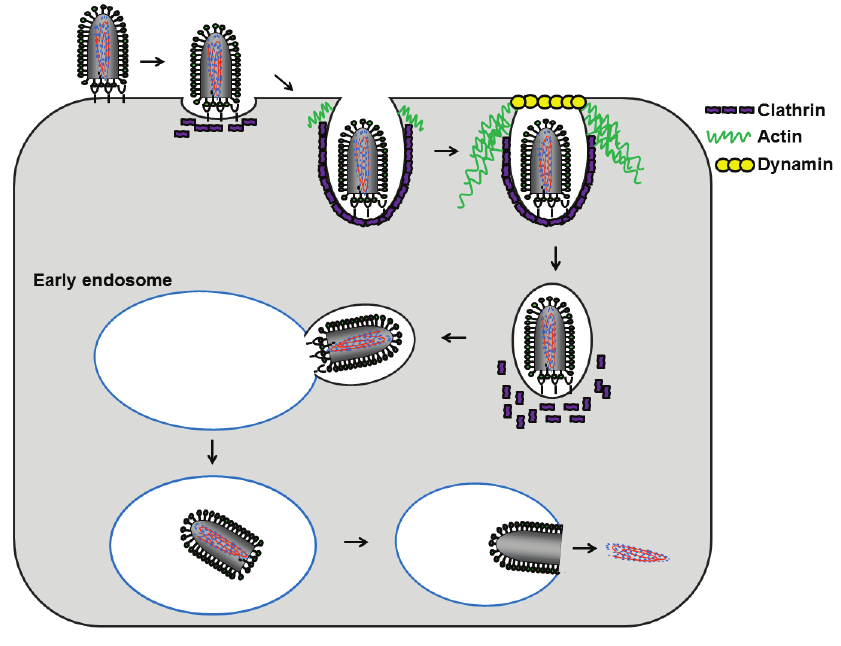
Figure 2. Lyssavirus host cell entry. Following attachment to host cell receptors, the virus particles are endocytosed via a clathrin- and dynamin- dependent pathway that requires actin polymerization for complete vesicle envelopment. The internalized uncoated vesicle then traffics to and fuses with the early endosome. The mildly acidic environment of the endosome triggers conformational changes within G that permits fusion of the viral and endosomal membranes and subsequent release of the nucleocapsid into the